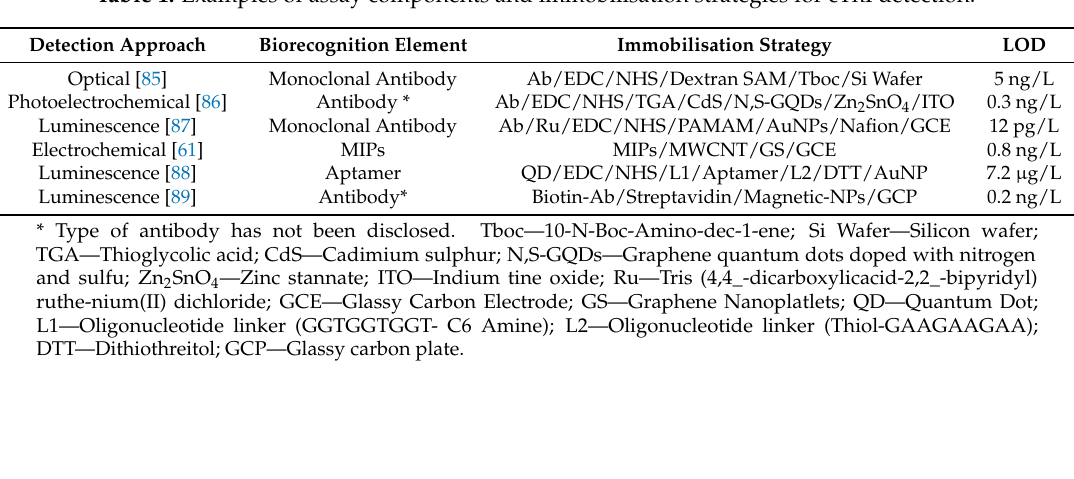
Table 1. Examples of assay components and immobilisation strategies for cTnI